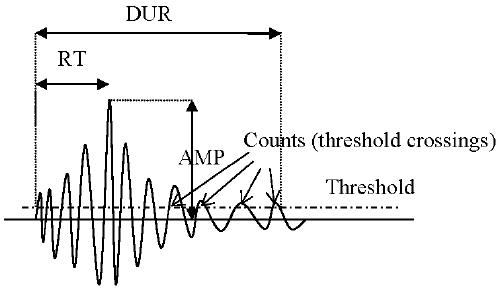
Figure 5. Typical AE waveform and its basic characteristics.